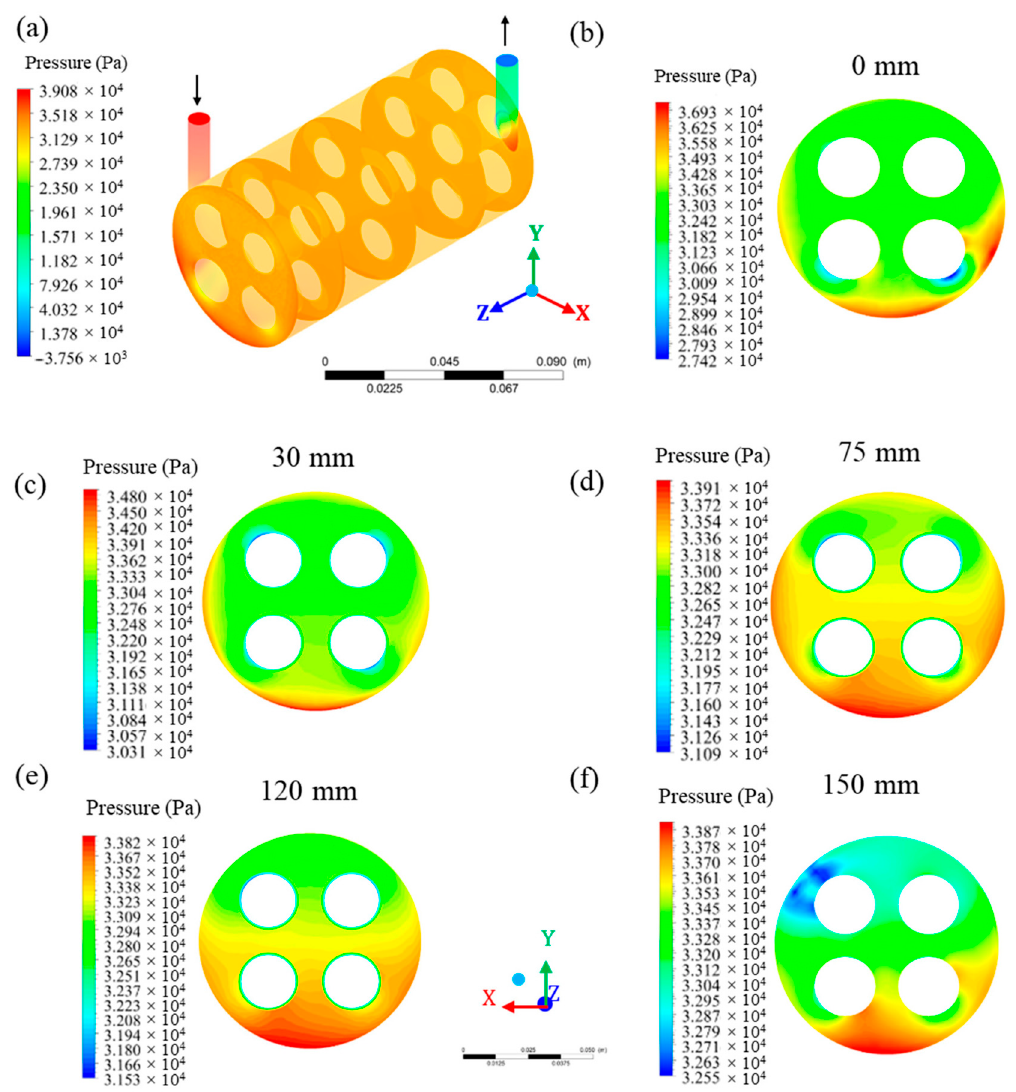
Figure 11. Pressure field in different regions of the hull. ( a ) Overview and in the xy plane at z = 0 mm ( b ), z = 30 mm ( c ), z = 75 mm ( d ), z = 120 mm ( e ), and z = 150 mm ( f ), of the filtration module during the water / oil separation process.